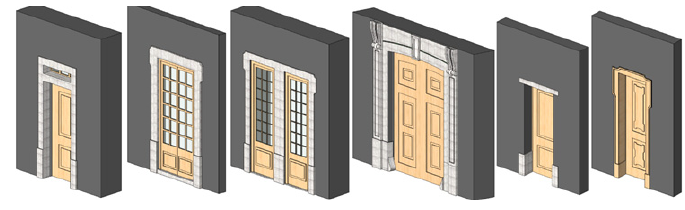
Figure 21. Distinct families of doors were generated.